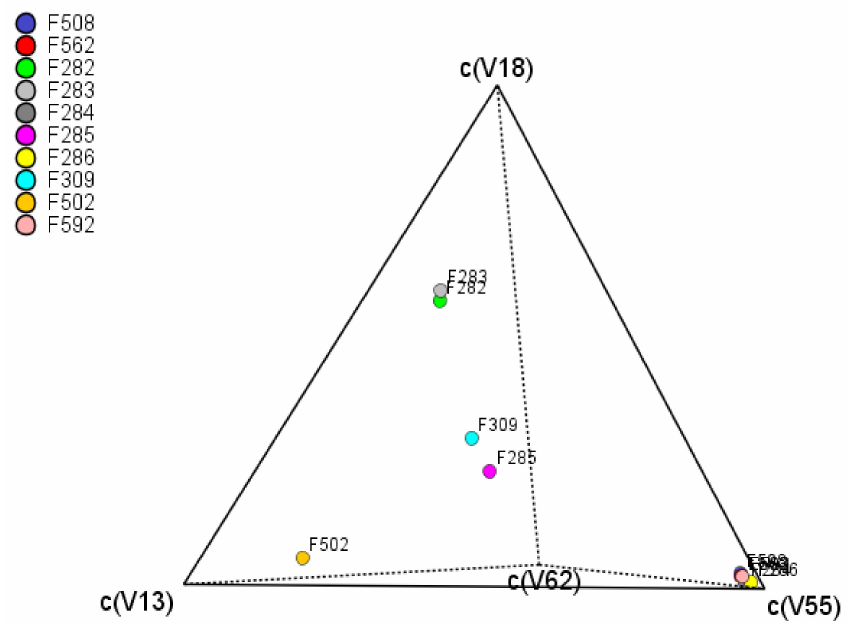
Figure 4. Tetrahedral centered plot of samples as function of the four VOCs with the highest clr variance (methyl butanoate (V13), ethyl butanoate (V18), 6-hepten-1-ol (V55), and butanoic acid